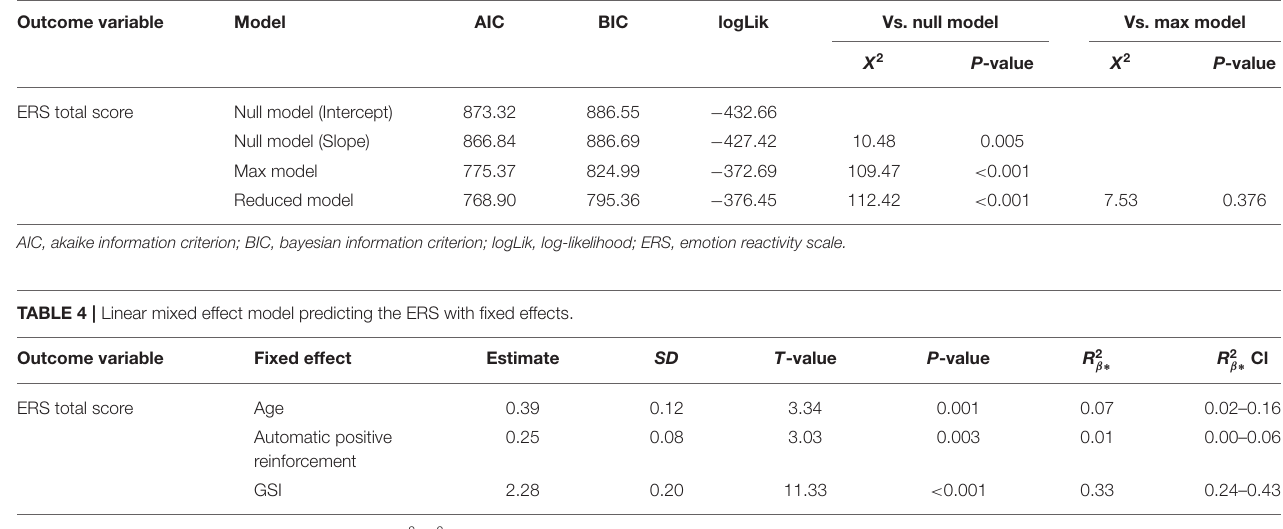
TABLE 3 | Model comparisons of linear-mixed effect models predicting the ERS total score.